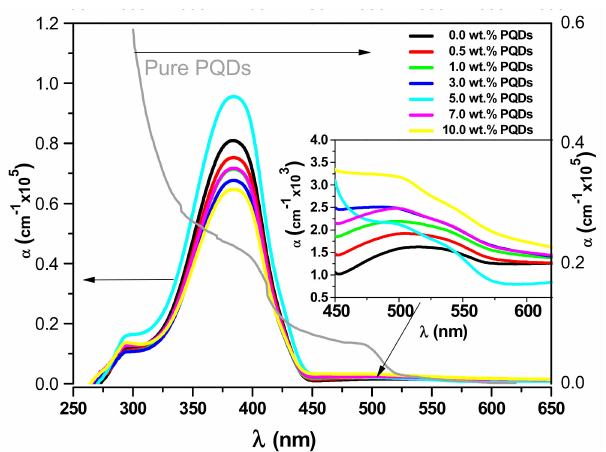
Figure 4. The absorption coefficient Spectra of the MEH − PPV/PFO hybrid, the CsPbBr 3 − PQDs, and the PQDs/(MEH − PPV/PFO) composite thin-films as a function of the wavelength. The inset shows the magnification of the absorption coefficient spectra in the range of 450–625